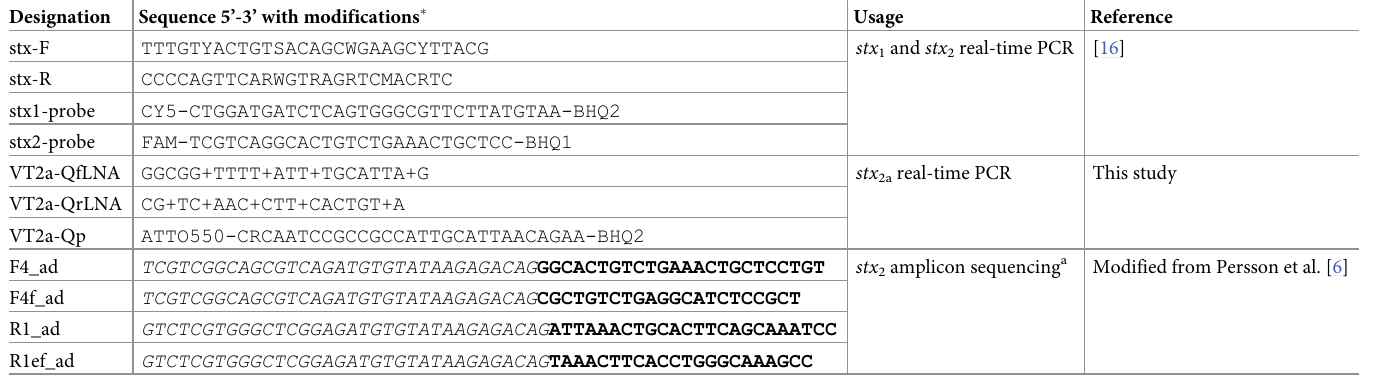
Table 1. Primers and hydrolysis probes used in this study for screening of Shiga toxin